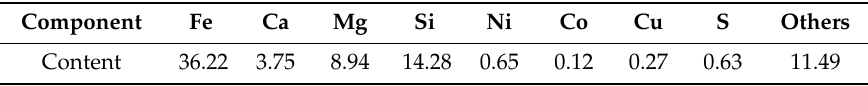
Table 1. Composition of nickel slag